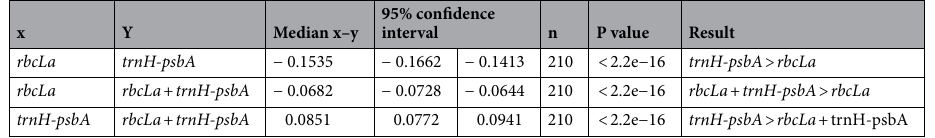
Table 7. Two sample sign-test of interspecific divergence among loci and both plastid barcodes concatenated.